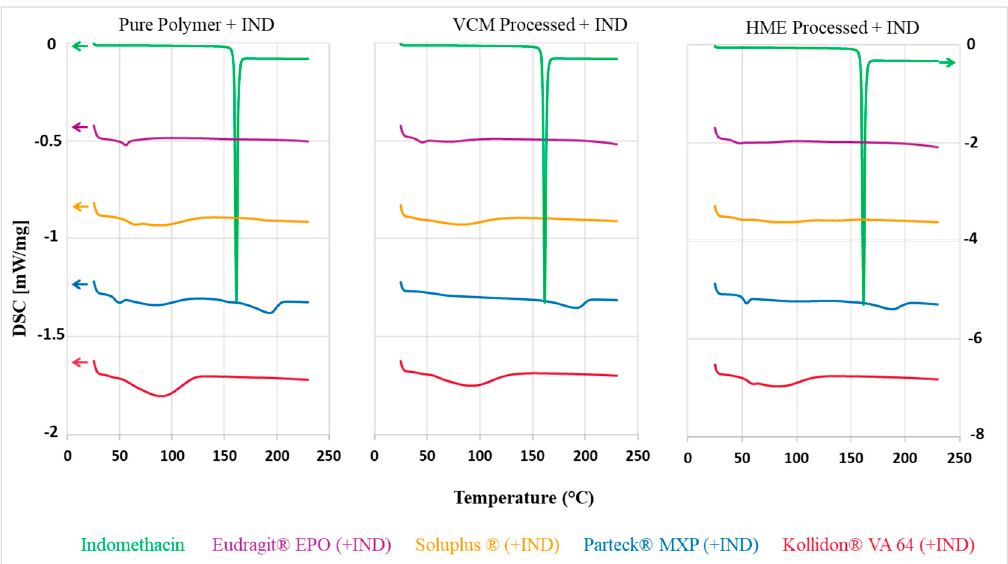
Figure 4. DSC thermogram left: neat polymers and IND; middle: milled VCM material from processed mixtures of polymers and IND (20 mm); right: milled HME material from processed mixtures of polymers and IND; heat flow offset used for better visibility.